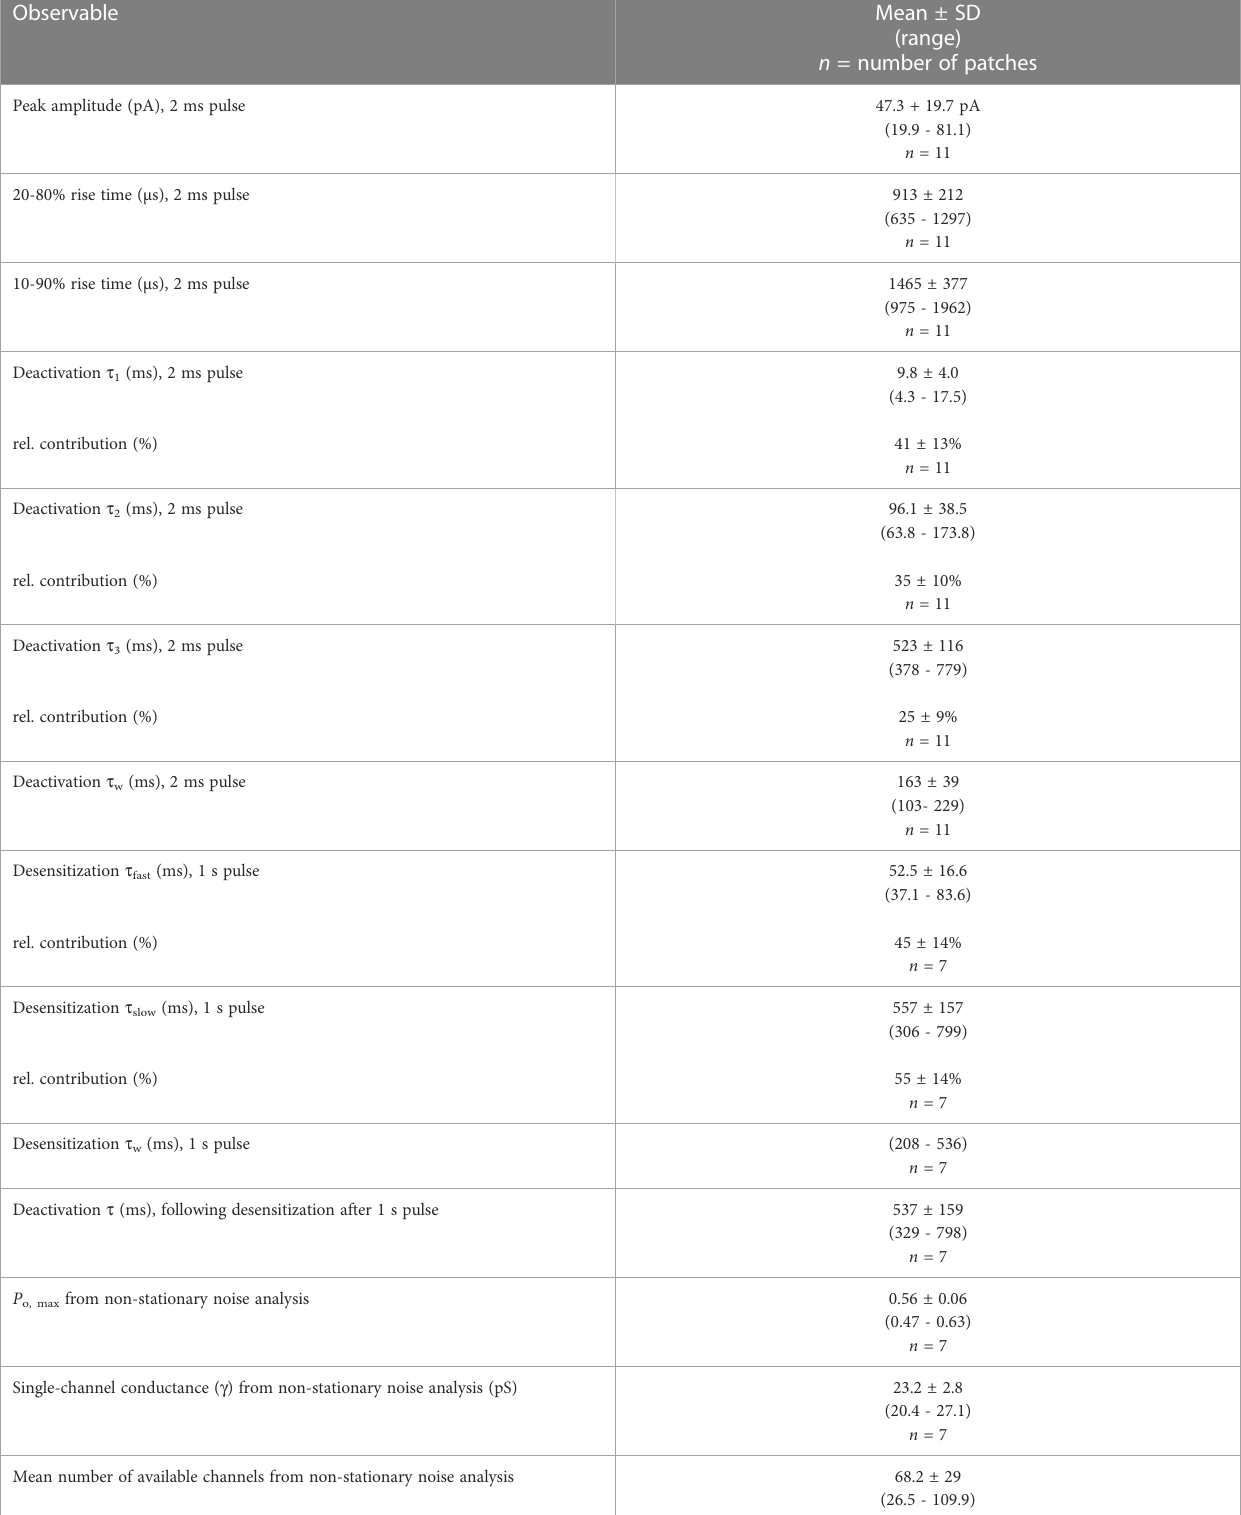
TABLE 1 Experimental measurements for GABA A receptors of AII amacrine cells in rat